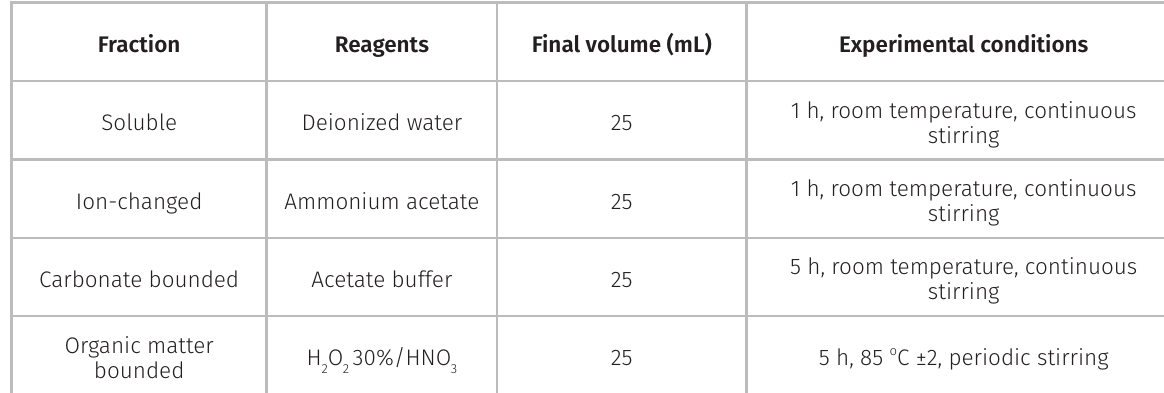
Table II. Procedures following each step of sequential